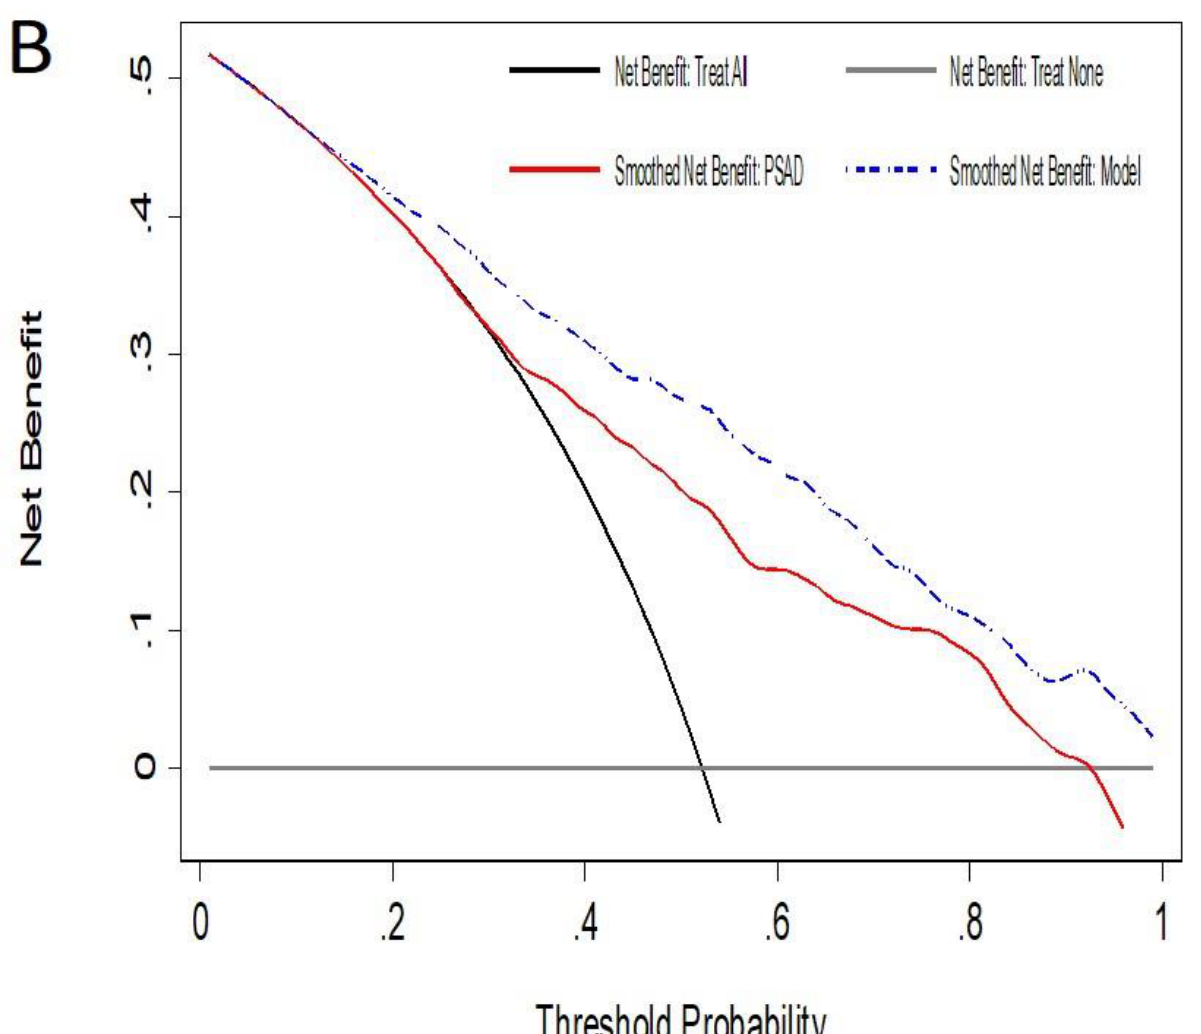
Figure 4. The ROC curves and AUCs show the efficacy of mPSAD (PSAD in the graphic) and MRI- PMbdex (model in the graphic) in detecting csPCa in men with PI-RADS 4 ( A ). The DCAs showing the net benefit of mPSAD and MRI-PMbdex over performing biopsies on all men according to the csPCa probability threshold ( B ).